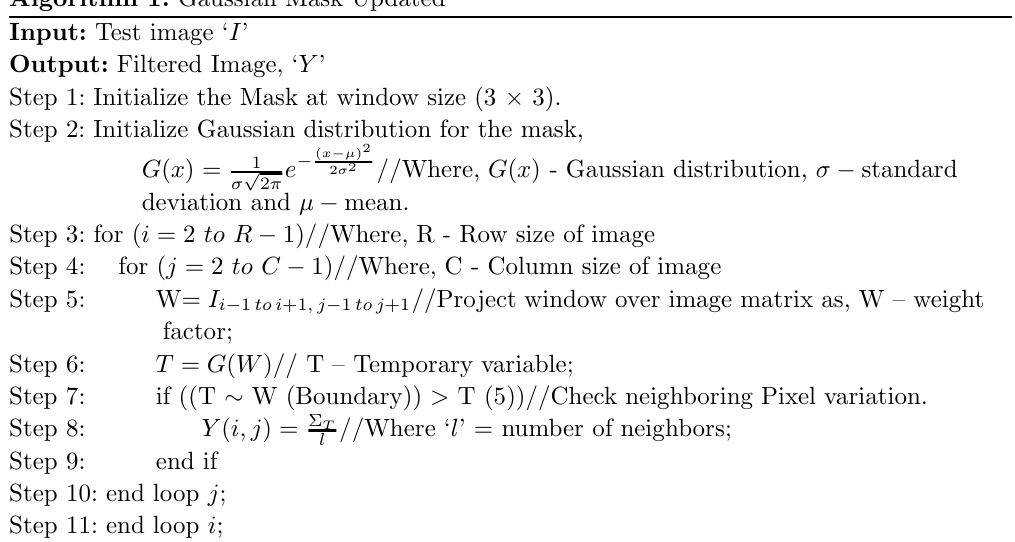
Algorithm 1. Gaussian Mask Updated